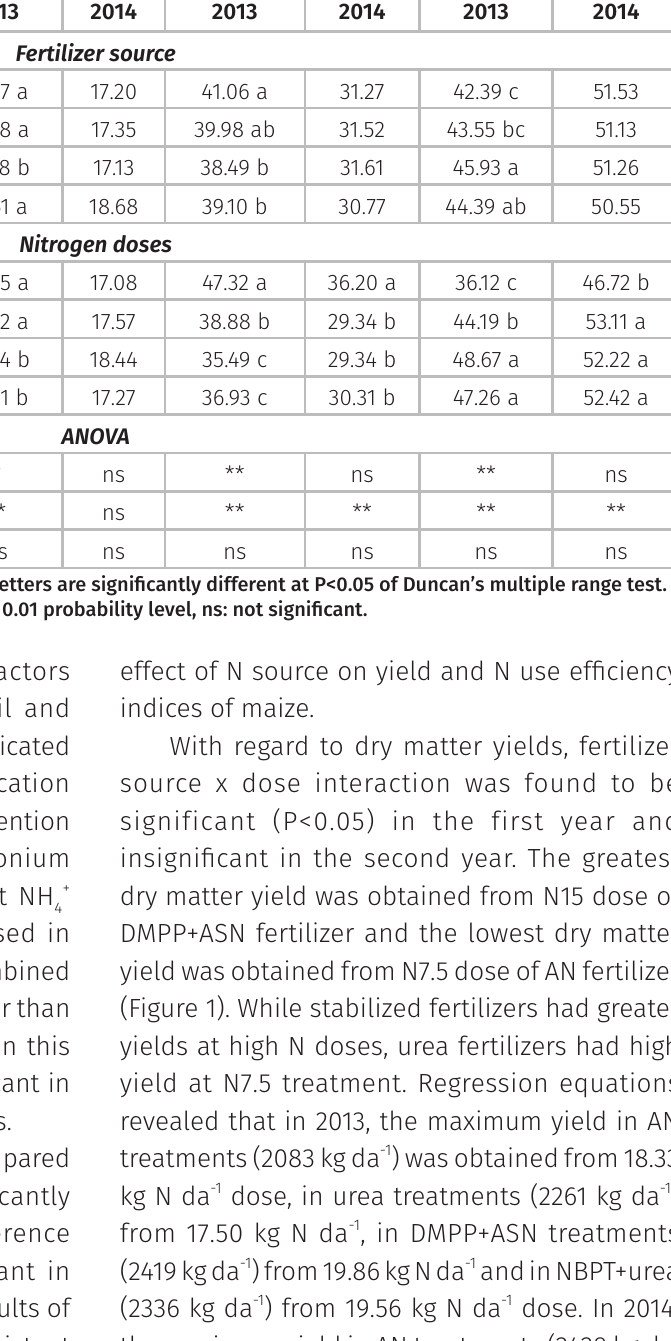
Table II. Effects of different nitrogen sources and doses on dry matter yield and distribution.